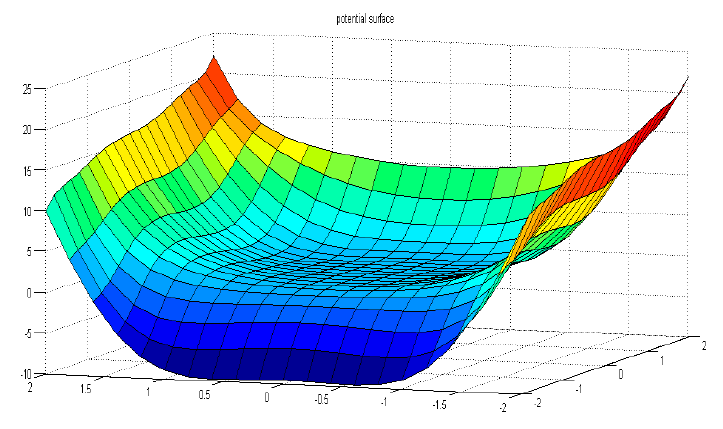
Figure 13. Potential surface obtained from the DE-APF scene in Figure 12.